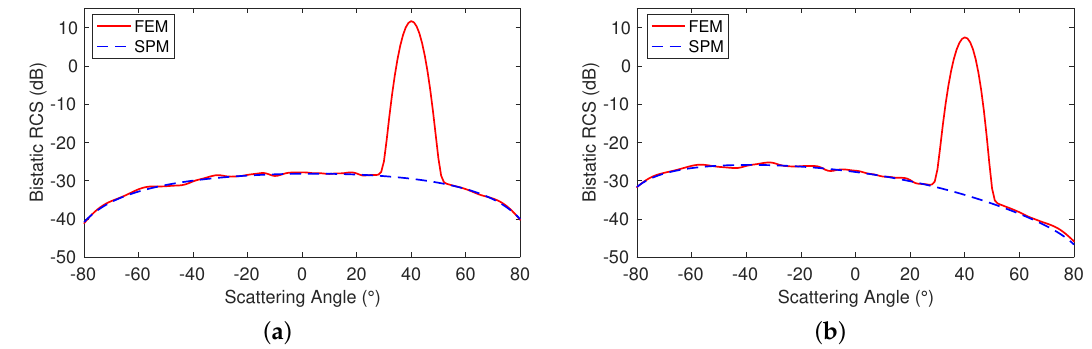
Figure 3. Bistatic RCS of ( a ) HH and ( b ) VV polarizations simulated by FEM and SPM for incidence angle θ i = 40 ◦ at